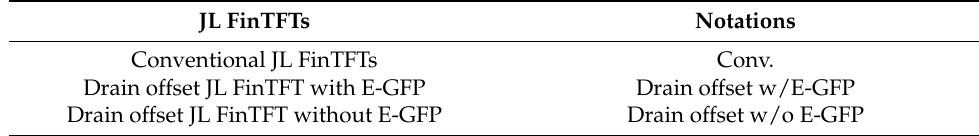
Table 1. JL FinTFT structures and